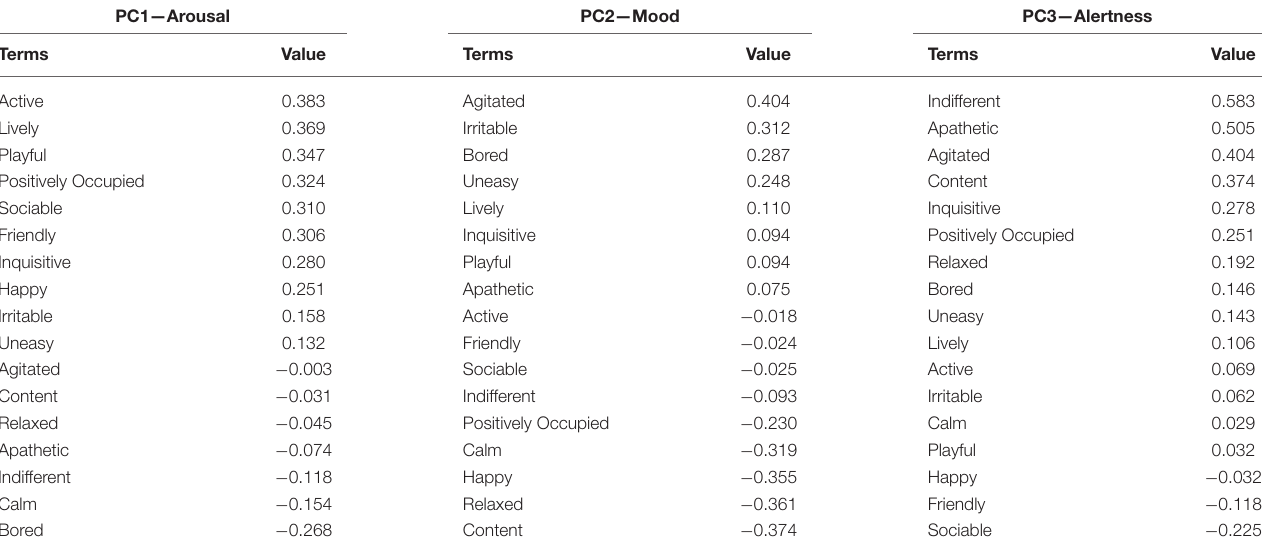
TABLE 2 | Loading values for each term across principal components one (PC1) and two